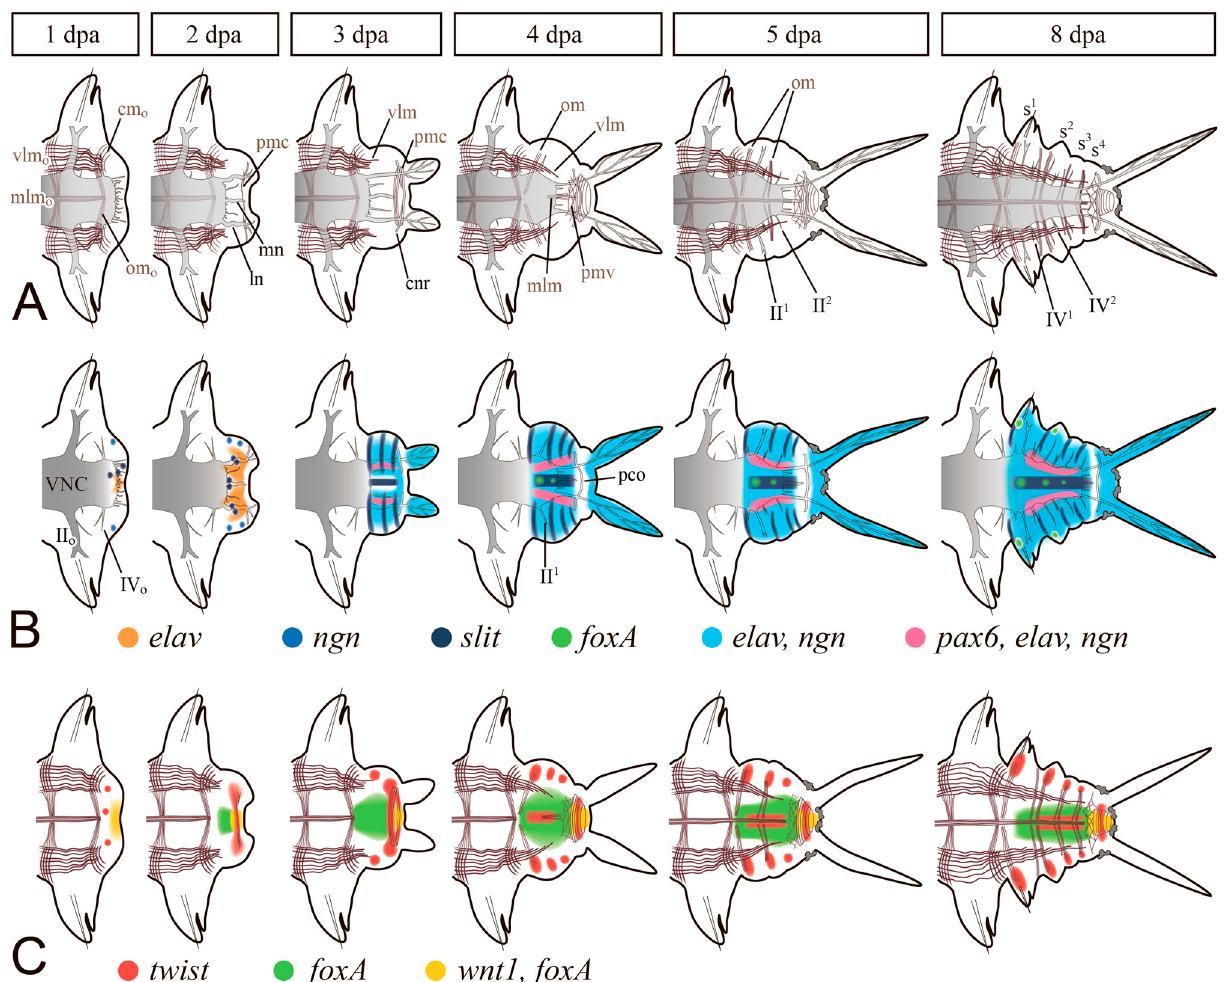
Figure 3. Dynamics of muscle and neural regeneration combined with corresponding gene expression patterns in nereid polychaetes ( Alitta virens and Platynereis dumerilii ). Ventral views and posterior body end (regenerative bud) is to the right. ( A ) Morphological illustration of muscles (brown) and nerves (grey fill) development. ( B ) Expression patterns of elav , neurogenin ( ngn ), slit , and pax6 in neurogenic tissues. ( C ) Expression patterns of twist in muscle precursors and foxA and wnt1 in intestinal tissues. II , IV , segmental nerves of VNC; cm , circular muscles; cnr , circumpygidial nerve ring; ln , VNC lateral nerve; mlm , ventral median longitudinal muscle; mn , VNC median unpaired nerve; om, oblique muscles; pco , pygidial commissure; pmc , pygidial circular muscles; pmv , network of ventral muscles in the pygidium; s , segments with external furrows; superscript symbol, serial number of regenerated segment, which possesses the structure, defined by the letter; subscript o in II o , IV o , cm o , mlm o , om o , and vlm o denotes affiliation of nerves and muscles to the old tissues of the stump. Modified after [12,34,39,79].